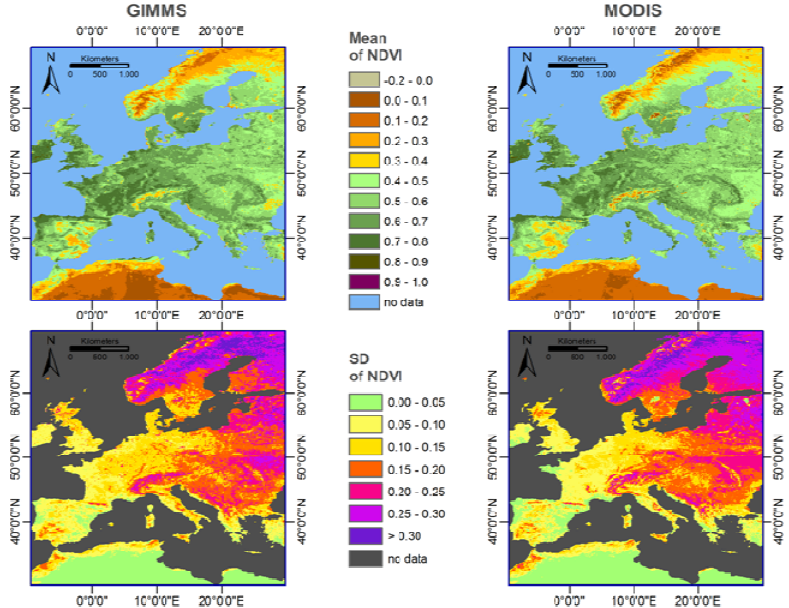
Figure 4. Spatial distribution of NDVI from GIMMS ( left ) and MODIS ( right ) time series. Displayed are the average NDVI ( top ) and standard deviation ( bottom ) calculated from weekly data over the full time period (2002–2011).